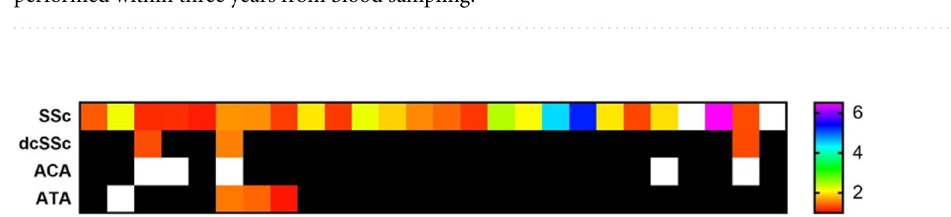
Table 1. Systemic sclerosis specific demographics and cardiac outcome measures of patients evaluated by panel A. Data are presented as mean (SD), median (IQR) or number (percentage). ACA anti-centromere antibodies, ATA anti-topoisomerase I antibodies, BMI body mass index, GLS global longitudinal strain, ILD interstitial lung disease, lcSSc limited cutaneous systemic sclerosis, mRSS modified Rodnan skin score, TAPSE tricuspid annular plane systolic excursion. Parameters of cardiac function are evaluated on echocardiographies performed within three years from blood sampling.